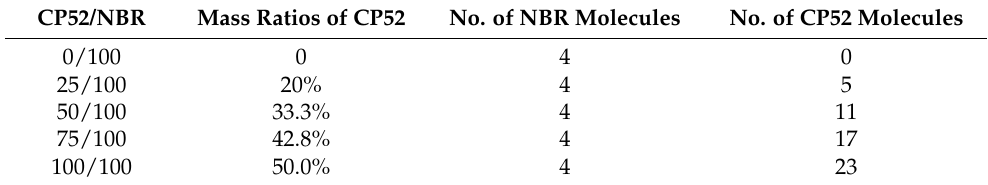
Table 1. The number of CP52 and NBR molecules in the cell.